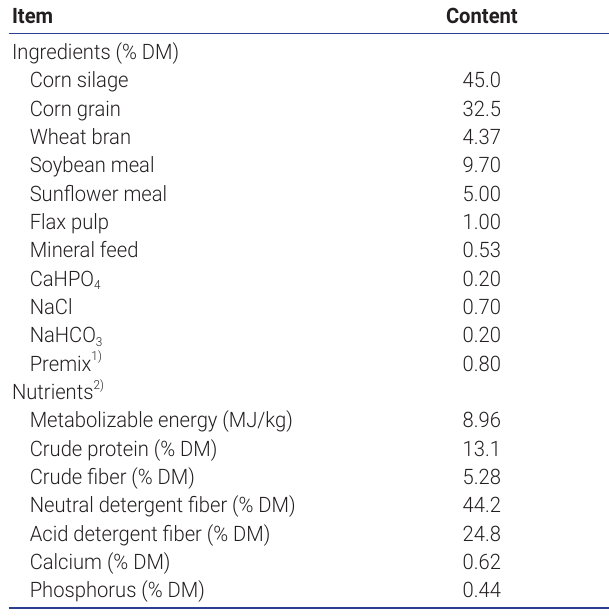
Table 1. Ingredients and nutrient composition of